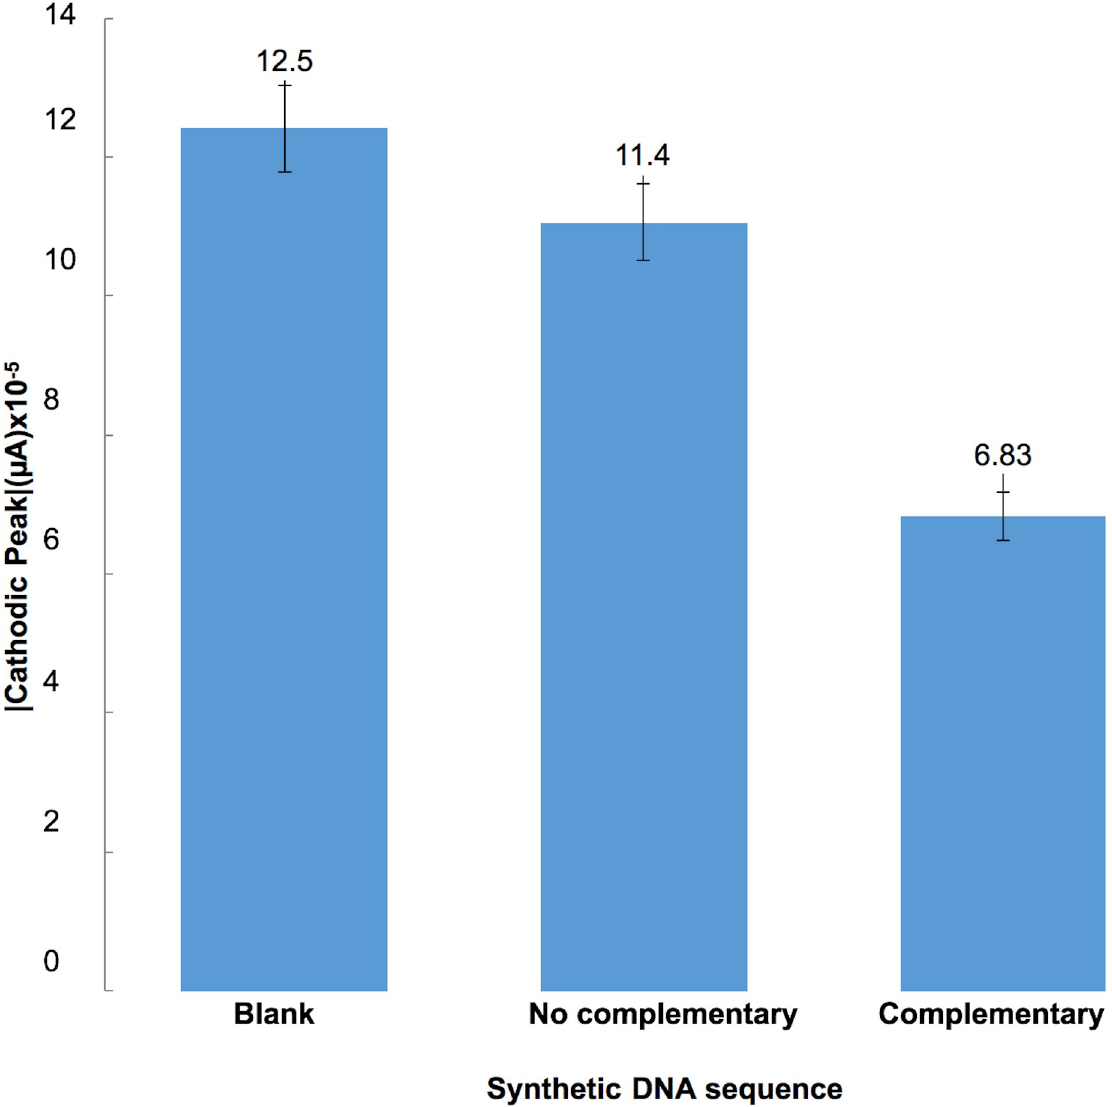
Fig 4. Sensor response represented by the behavior of the absolute value of the cathodic peaks towards samples without synthetic DNA (BLANK), samples with 50nM of non-complementary synthetic DNA sequence and samples with 50nM of complementary synthetic DNA